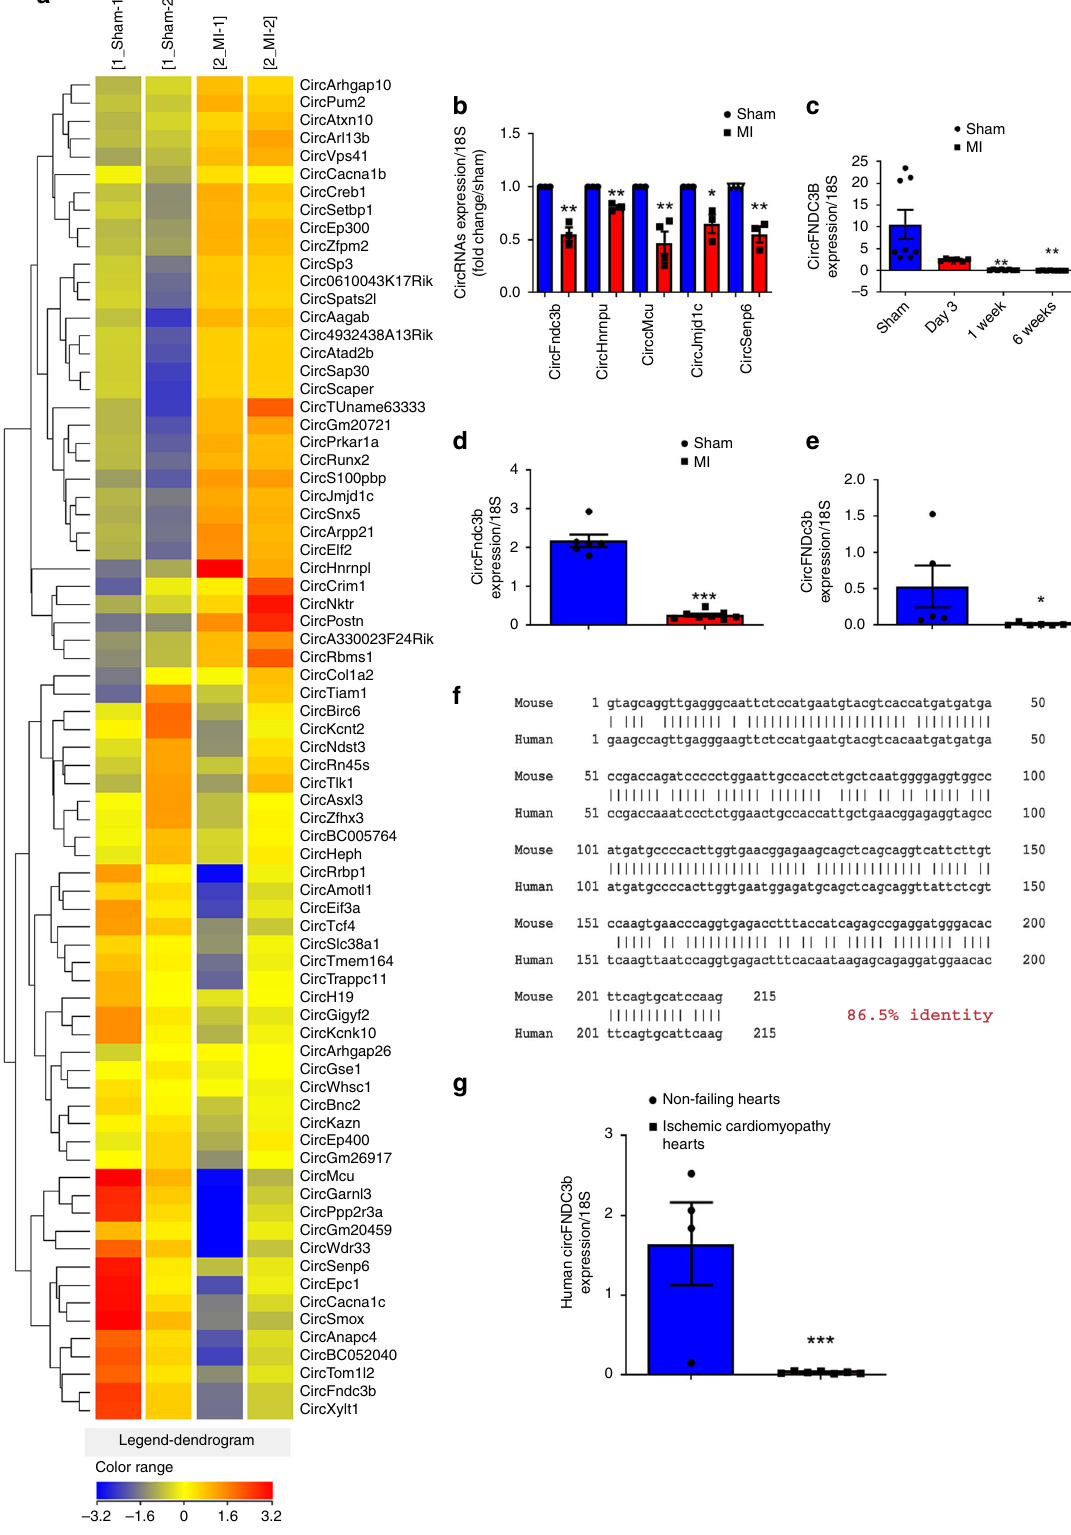
subjected to H 2 O 2 (100 µM) stress for 24 h (Supplementary Fig. 4G – I). In total, these results demonstrate that circFndc3b overexpression generally reduces apoptosis in cardiomyocytes in vitro.